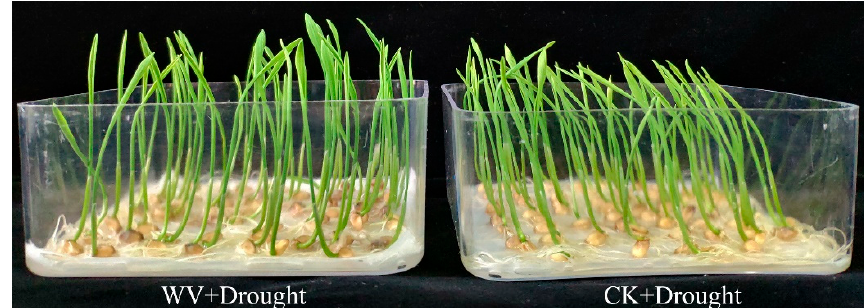
Figure 2. Phenotypic changes of wheat seedlings in both the control and WV treated groups under a drought stress treatment for 2 days. The concentration of WV was 0 and 1:900 in control and WV treated groups, respectively. Drought stress was simulated with PEG 6000( − 1 MPa).